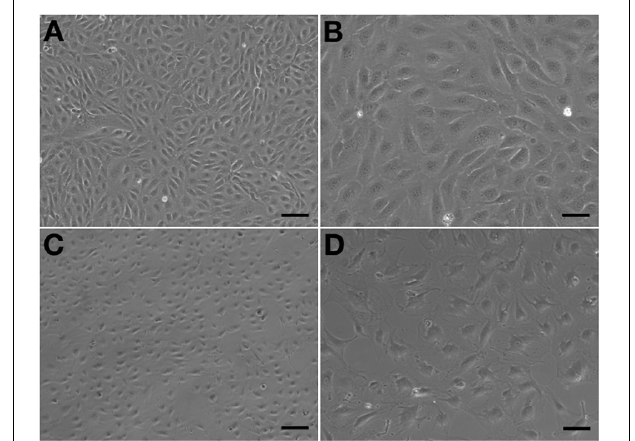
FIGURE 2 | Morphology of human aortic endothelial cells (HA-ECs) and cAVM-ECs. (A,B) Morphology of HA-ECs under microscope in (A) 40 × , Scale bar = 100 µ m; (B) 100 × , Scale bar = 50 µ m, showed classical round borders and cobblestone appearance; (C,D) showed irregular borders and flatty bodies with smaller nuclei, (C) 40 × , Scale bar = 100 µ m; (D) 100 × , Scale bar = 50 µ